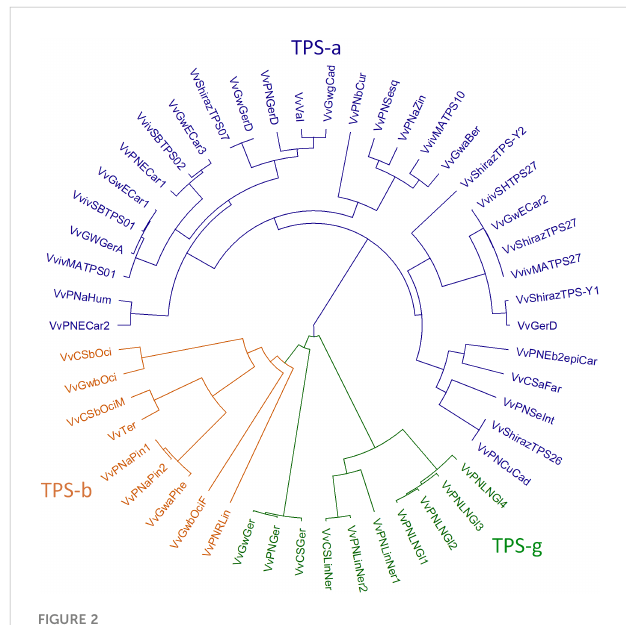
FIGURE 2 Phylogenetic tree of characterised grapevine terpene synthases. The TPS- subfamilies a, b and g are indicated in blue, orange and green,